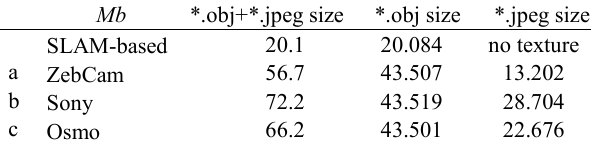
Table 5. ZEB-based triangulated surfaces files texturized according to a, b,